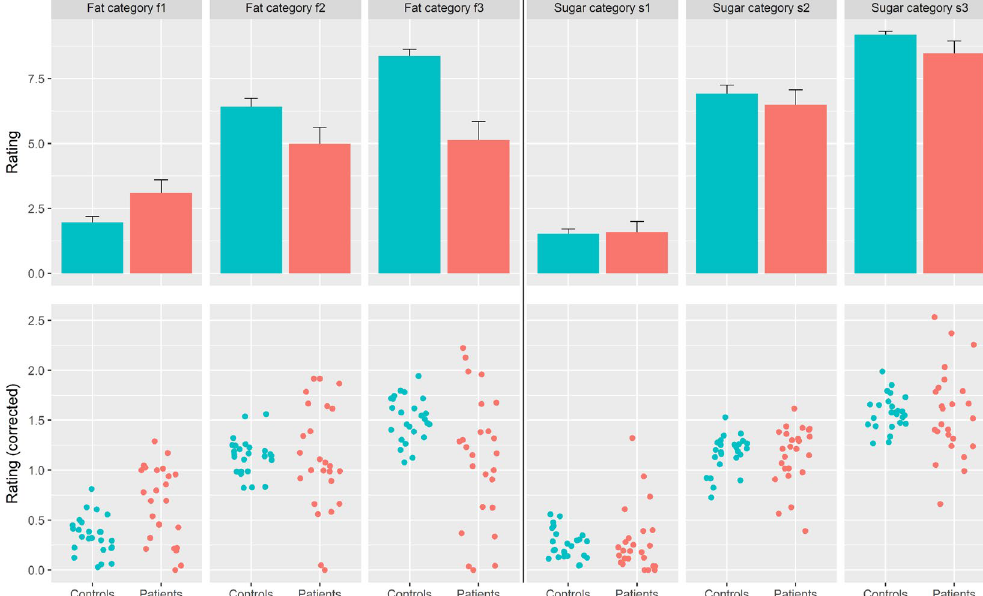
Figure 1. Sugar and fat ratings. Shown are patients’ and controls’ sugar and fat ratings for the three chocolate milkshakes containing increasing amounts of either sugar (s1 to s3) or fat (f1 to f3). ( a ) The bar plots represent the mean, the whiskers the standard error of the absolute ratings of patients (red) and controls (green) ( b ) The scatter plots show the mean-corrected ratings of each participant. Patients are colored in red, controls in green. We found no significant differences in sugar ratings between patients and controls. For fat ratings, we found significant differences for f1 and f3, but not for